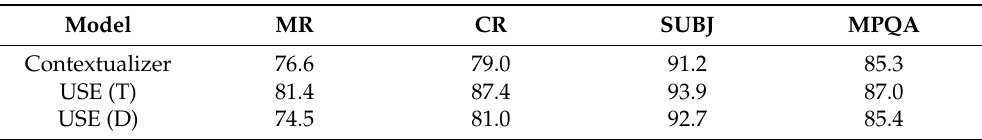
Table 4. Test accuracy (%) on several benchmark text classification tasks of our Contextualizer models compared to the Universal Sentence Encoder architectures (USE), Transformer-based (T) and Deep-Averaging-Network-based